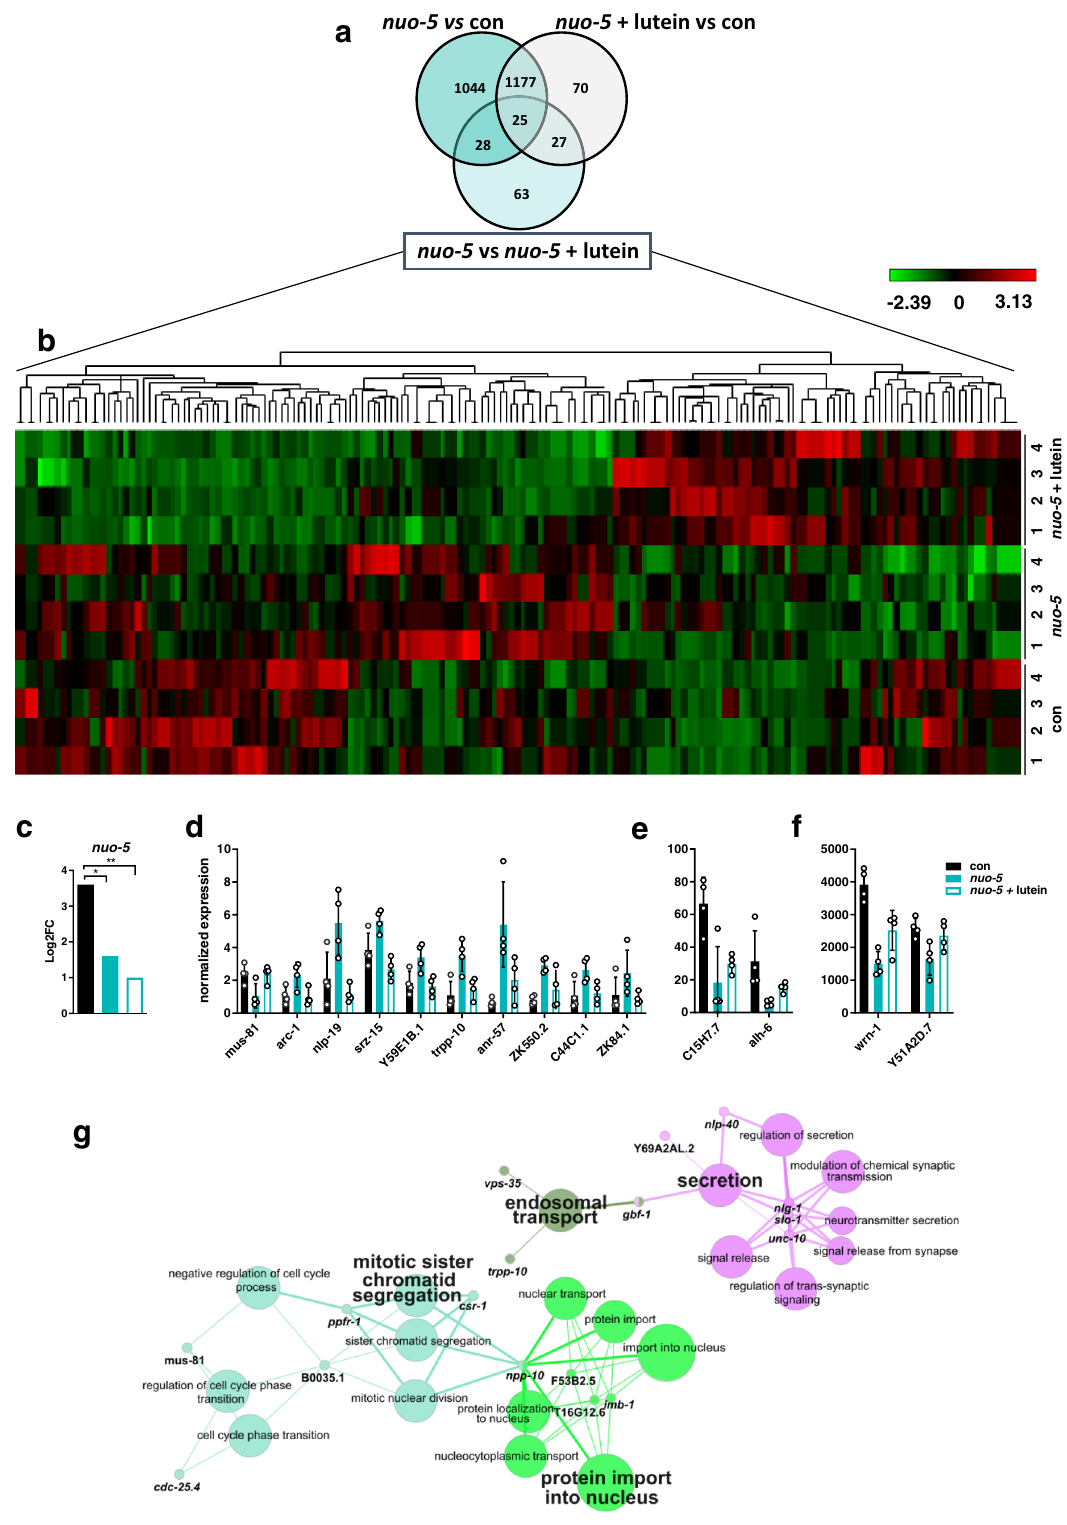
aldicarb sensitivity assay to the degree of the wild-type animals (Fig. 8g) con fi rming lutein works through suppression of nlg-1 . Overall, we revealed a pathogenetic role for nlg-1 overexpression upon mitochondrial dysfunction, which mediates an altered synaptic functionality restored by lutein, thus pointing towards a novel potential targeted therapeutic for the corresponding human